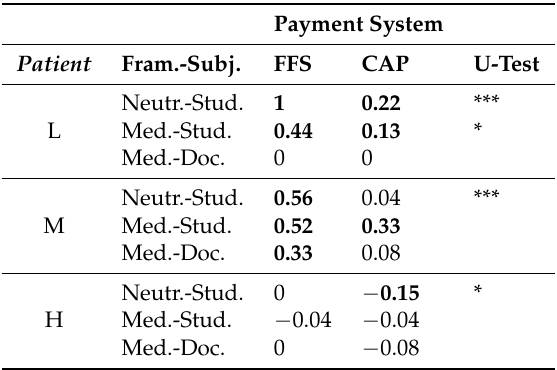
Figure A1. Average misreporting across experimental conditions. Notes: This figure illustrates average misreporting and 95% confidence intervals across experimental conditions. Misreporting refers to the case where the reported Patient type differs from the true Patient type. Positive misreporting corresponds to overreporting, while negative misreporting corresponds to underreporting. Each subject decided on the reporting and provision of (medical) services of every Patient type. Therefore, the total number of observations is 126. Number of observations in respective treatments: CNS—27, CMS—24, CMD—12, FNS—27, FMS—27, FMD—9. Tables A4–A6 (in the Appendix B) contain the average misreporting values and tests for significant differences. Table A1. Misreporting between fee for service and